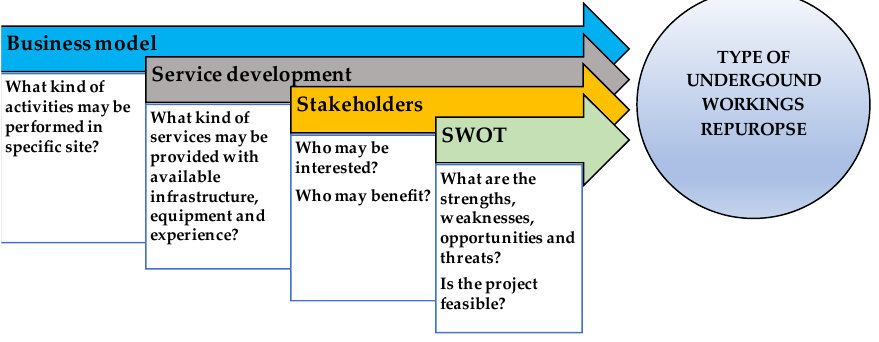
Figure 7. The topics which need to be solved during the identification of stakeholders.